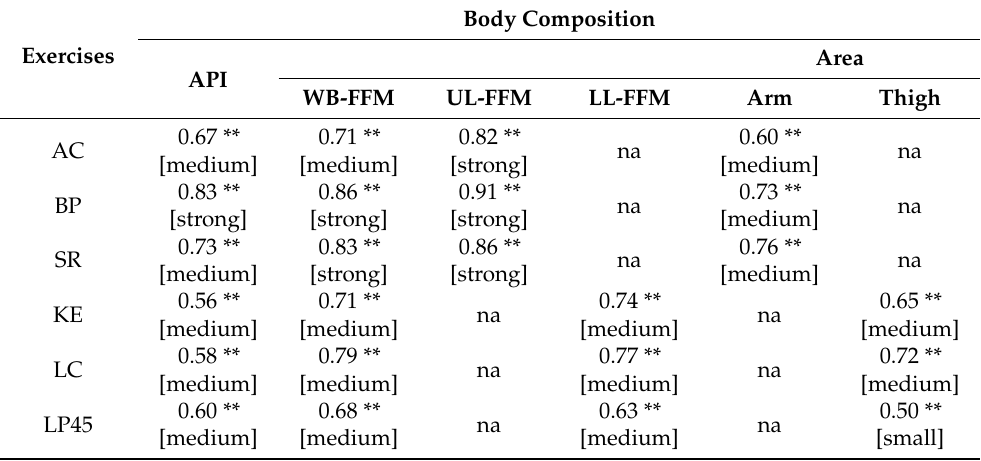
Table 2. Coefficients for Pearson’s correlation analysis between 1RM values and regional and whole- body composition